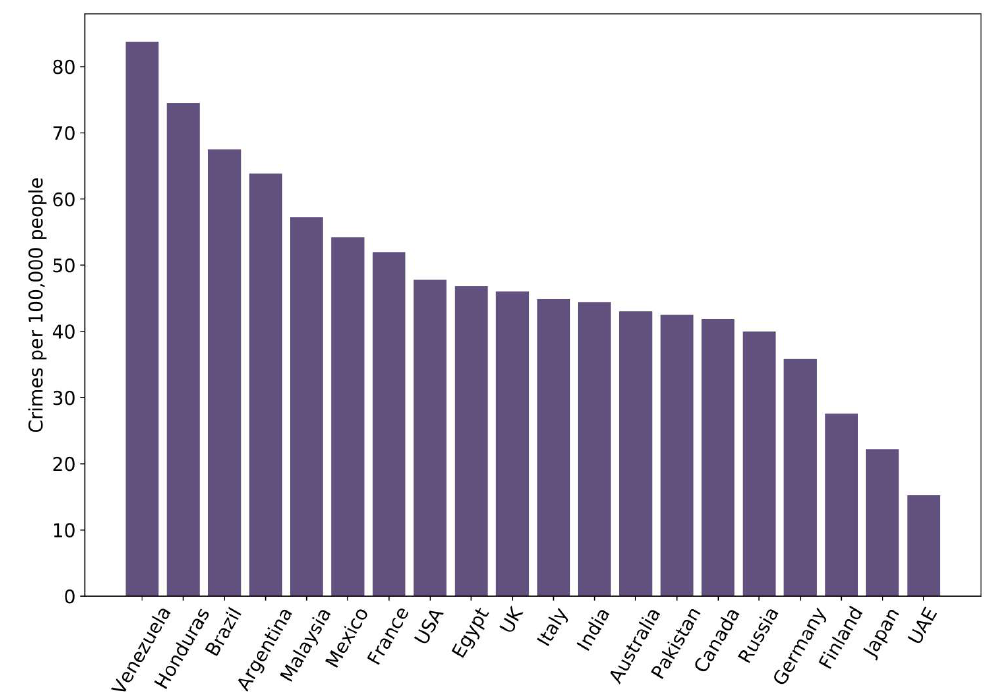
Figure 1. Global crime index